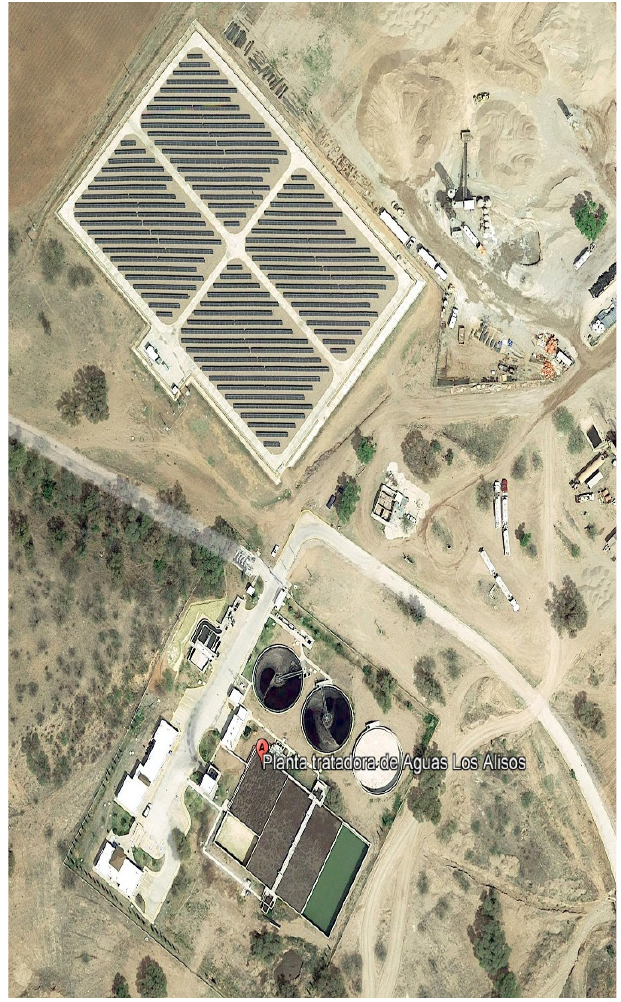
Figure 6. Solar-powered wastewater treatment plant in Nogales, Mexico [75].